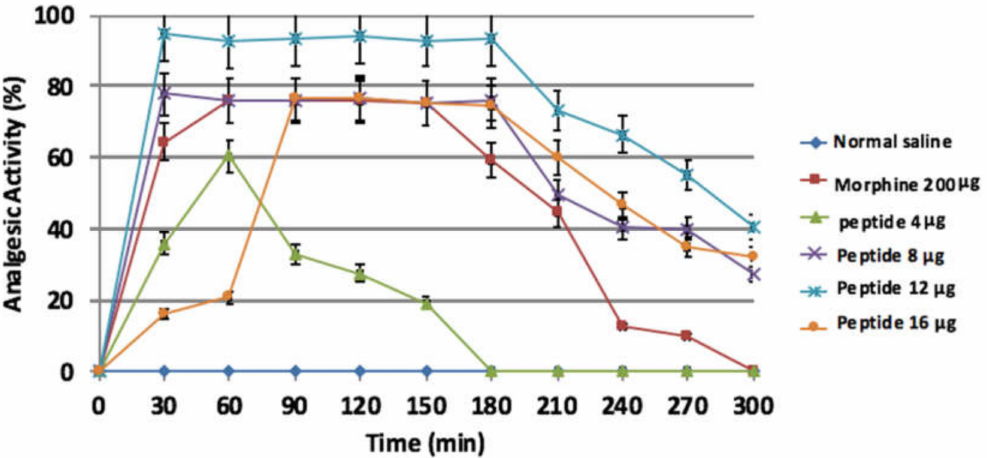
Figure 9. Hot plate assays. The maximum analgesic activity was 95% at 0.48 mg/kg (12 µ g/mouse) after 30 min and continued up to the time point of 180 min. Data is expressed as mean ± SD. All groups had n =